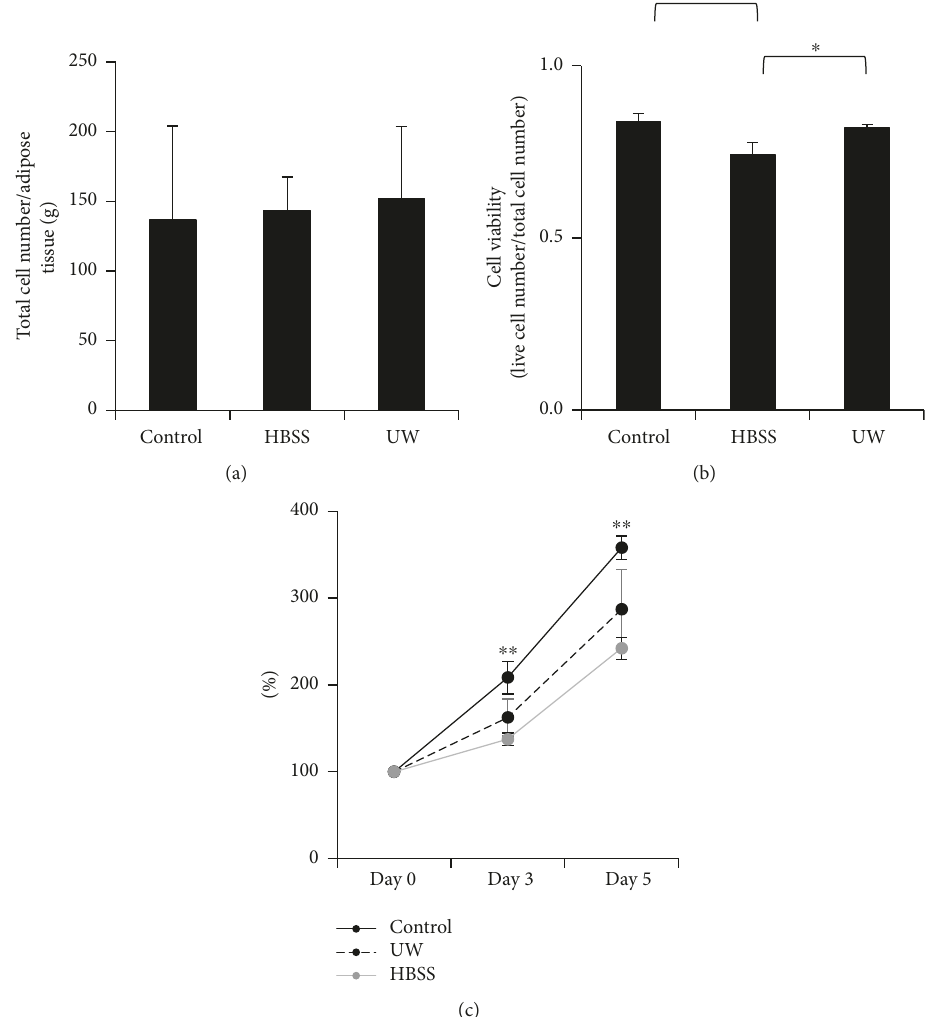
Figure 3: Total cell number and cell viability of ADSCs after preservation for 16h in Hank ’ s balanced salt solution (HBSS) or University of Wisconsin (UW) solution. Graphical representation of the total number of cells yielded from 1 gram of mouse adipose tissue after overnight preservation in UW and HBSS. ADSCs isolated without preservation served as control group (a). Cellular viability was determined by counting the number of live cells (not stained with 0.4% w / v Trypan blue solution) under a microscope. The decrease in cell viability of the HBSS group compared with both the control and UW groups was signi fi cant. Data are expressed as the mean ± SE (control group: 0.83 ± 0.03, HBSS group: 0.74 ± 0.03; ∗ P < 0 05 . UW solution group: 0.82 ± 0.01; ∗ P < 0 05 , n = 3 ) (b). Cell proliferation rate in the HBSS group on days 3 and 5 was signi fi cantly lower than that of the control group. Data are mean ± SE. The relative value is shown with the number of cells on day 0 as 100%. Day 0 (control group: 100.0 ± 0.0, UW group: 100.0 ± 0.0, HBSS group: 100.0 ± 0.0, n = 5 ). Day 3 (control group: 208.5 ± 18.9, UW group: 162.5 ± 21.2, HBSS group: 137.5 ± 7.1; ∗∗ P < 0 01 , n = 5 ). Day 5 (control group: 358.0 ± 13.7, UW group: 287.0 ± 45.4, HBSS group: 242.3 ± 12.9; ∗∗ P < 0 01 , n = 5 )